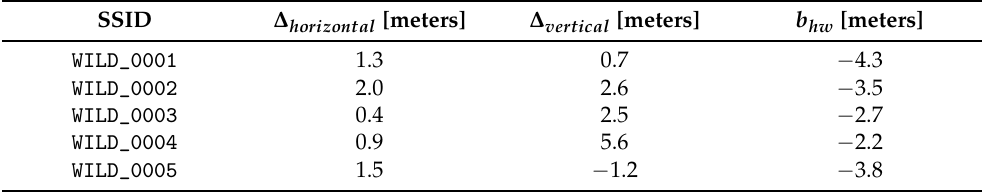
Table 5. Results with RTT measurements tagged with the Jason Position . Horizontal and vertical position deviations relative to the reference WAP positions and computed WAP hardware